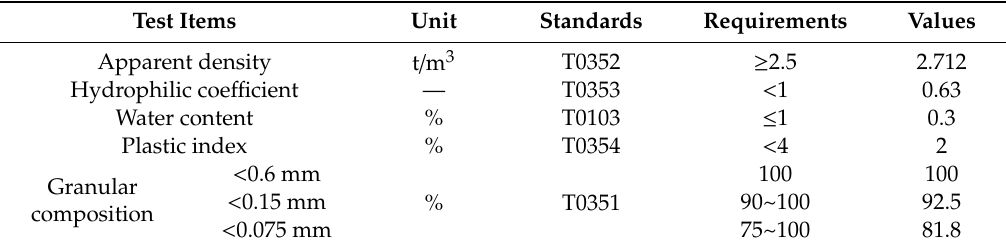
Table 4. Technical properties of limestone mineral filler.